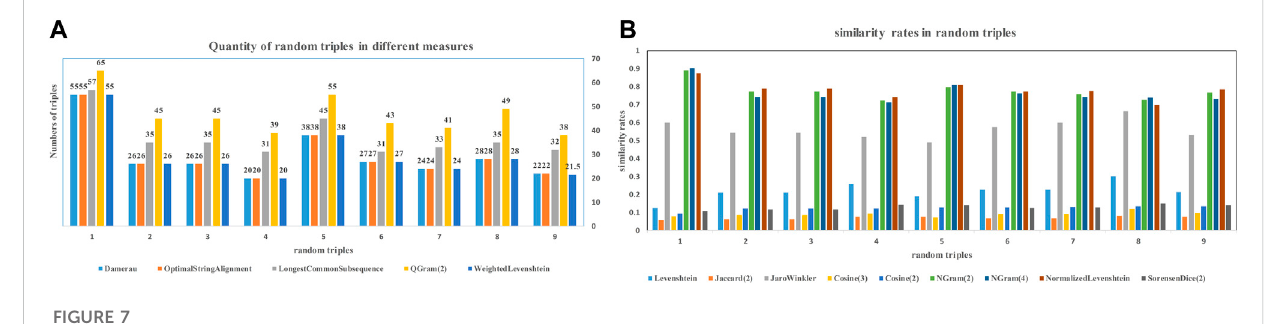
FIGURE 7 Comparison of similarity measures.